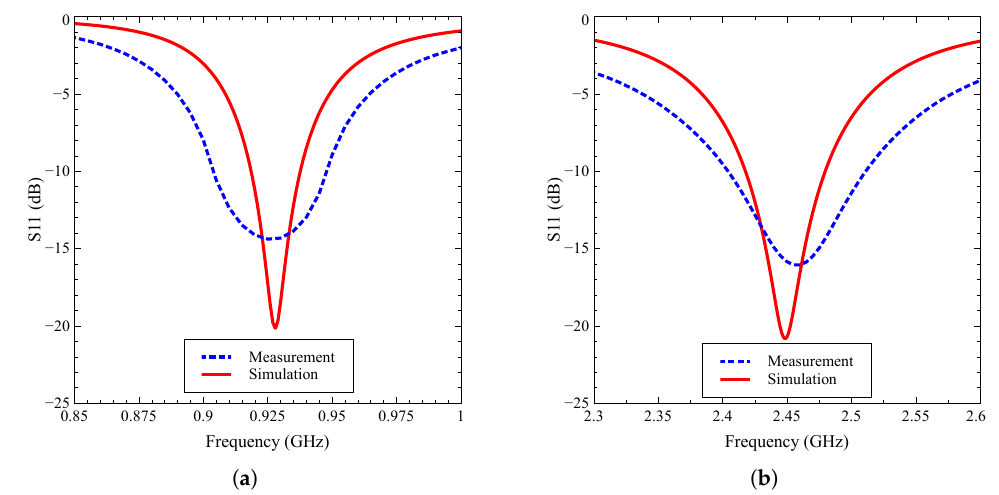
Figure 14. Simulation and measurement reflection coefficient of the rectifier at ( a ) low-frequency band and ( b ) high-frequency